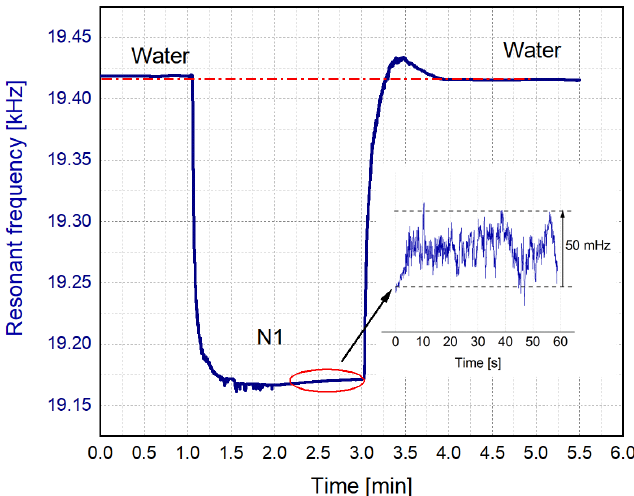
Figure 16. Real-time measurement of the resonance frequency while the sequence of water-N 1 -water liquids circulated through the liquid cell. Inset: Frequency stability for the model solution N 1 after a recirculation time of one minute.